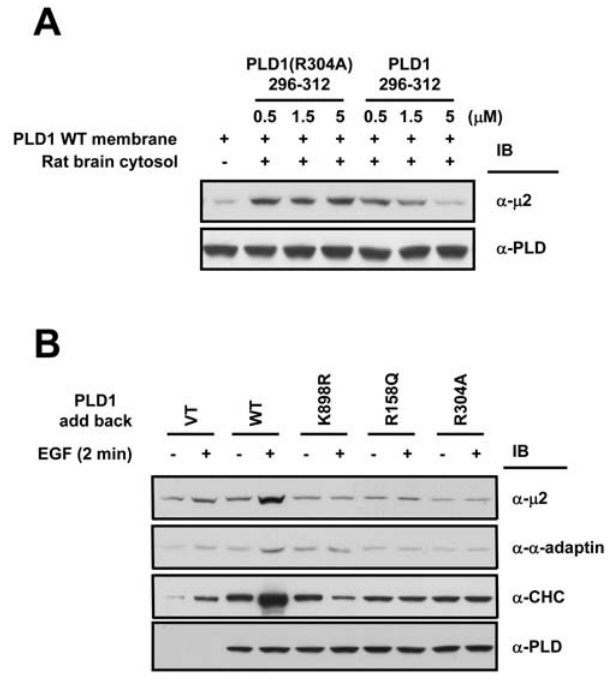
Figure 4. The PLD1- m 2 interaction is important for adaptor recruitment onto membranes. (A) Purified GST-fusion PLD1 296–312 or PLD1 296–312 (R304A) was added to recruitment assay mixture containing membrane preparation from wild type PLD1-expressing HeLa cells and rat brain cytosol (10 mg/ml). Membrane-recruited m 2 was detected by western blotting. Data are representative of two indepen- dent experiments. (B) Translocation of endocytic proteins onto plasma membrane was analyzed. HeLa cells transfected with vector, wild type, K898R, R158Q, or R304A PLD1 were treated with EGF (20 nM) during 2 min and the membrane preparations were subjected to SDS-PAGE and immunoblotted using the indicated antibodies.